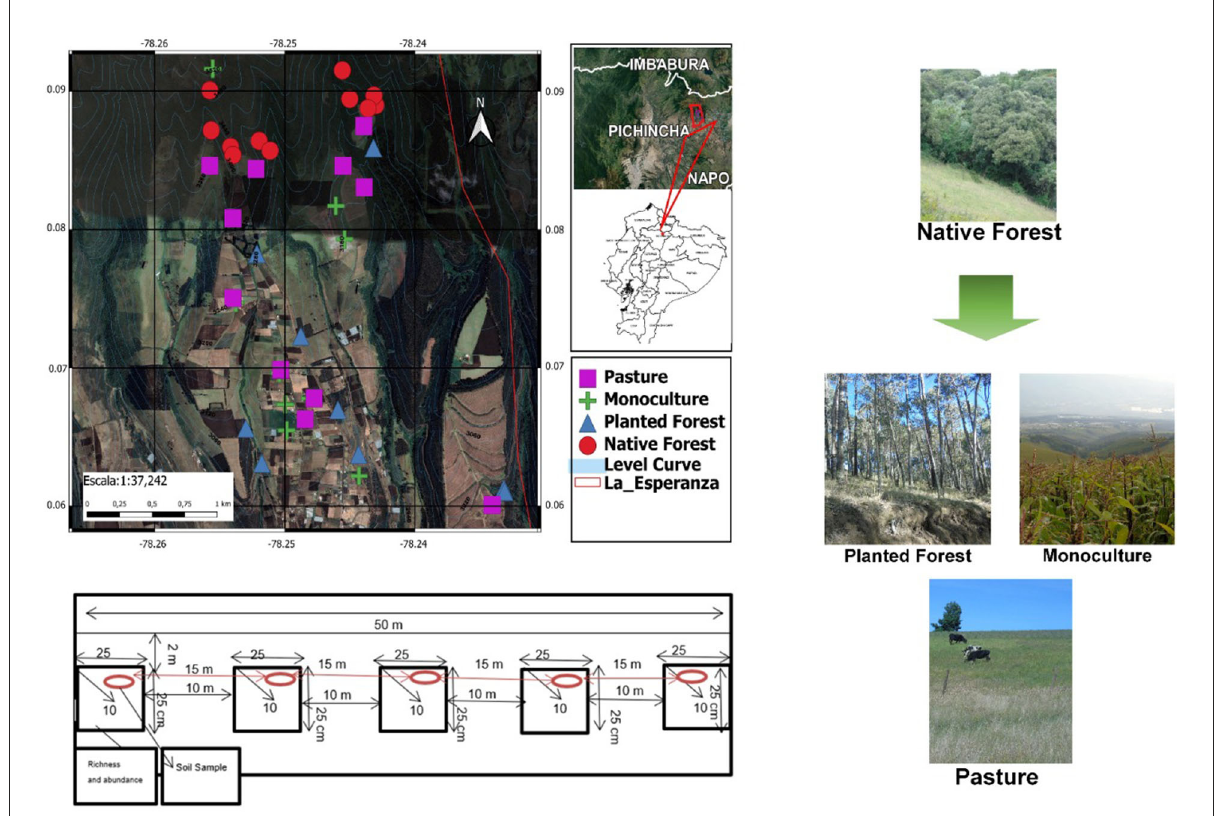
FIGURE1 Study site location, representation of land use categories and diagram of the soil sampling